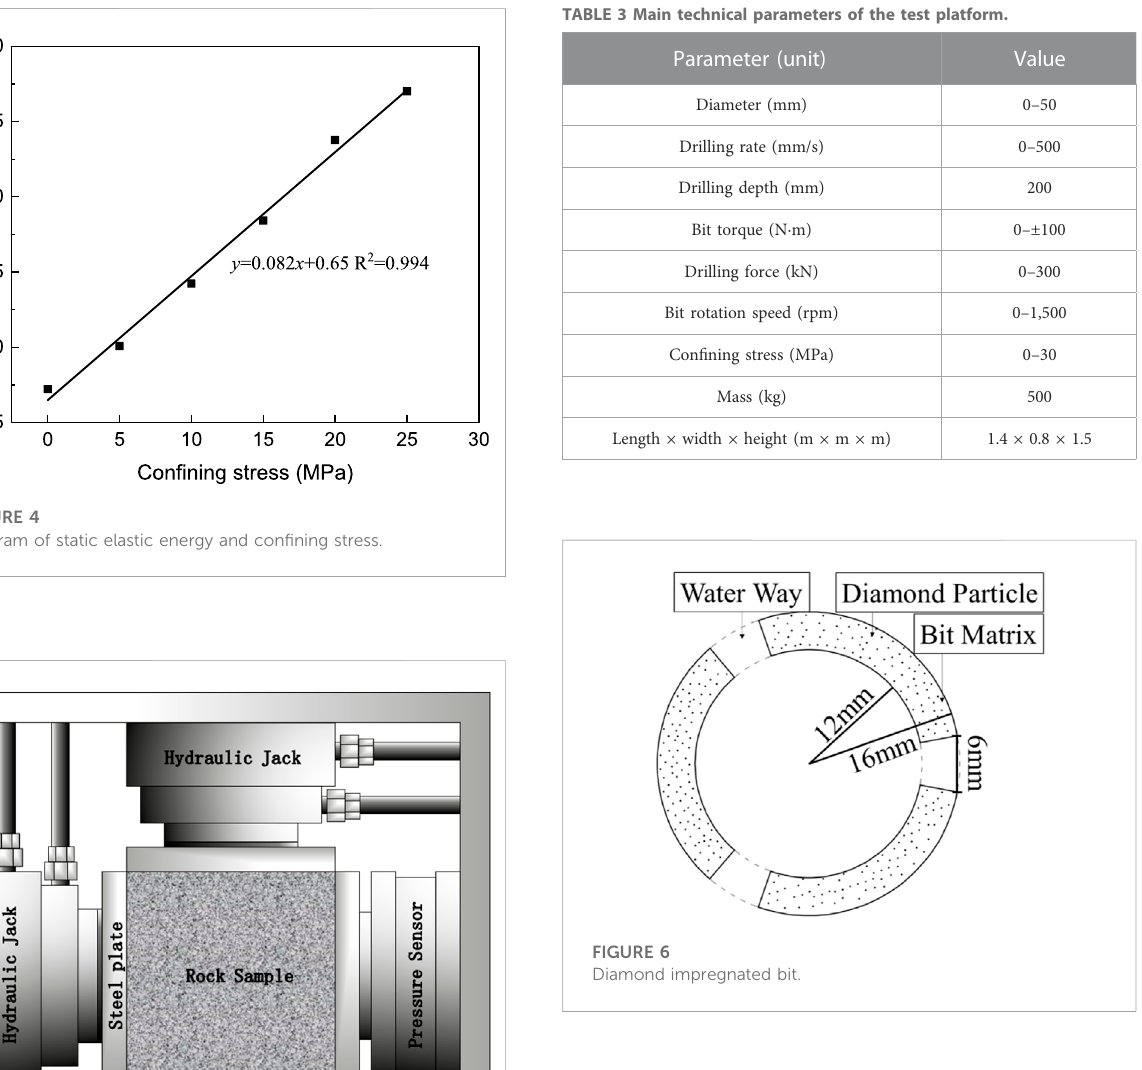
FIGURE 5 Internal structure of con fi ning stress system.